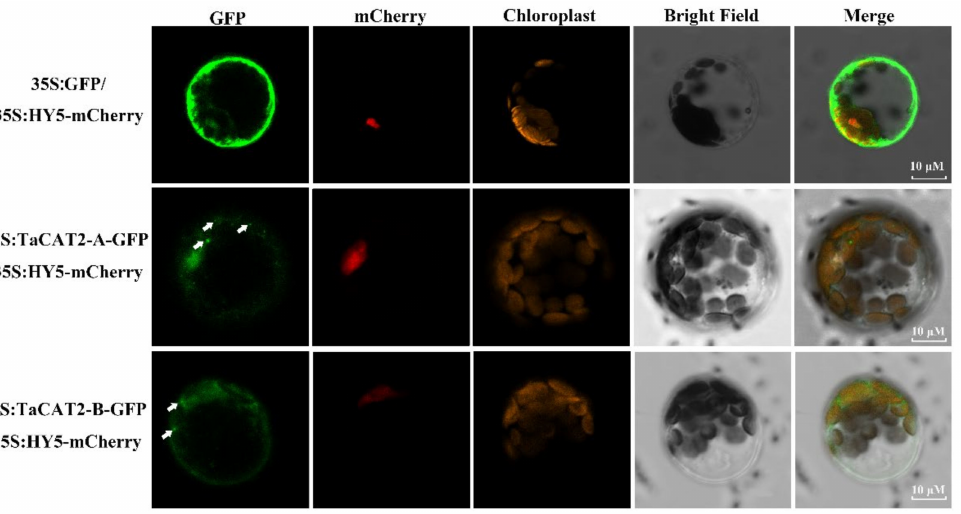
Figure 8. Subcellular localization analysis of TaCAT2-A and TaCAT2-B proteins in protoplast. TaCAT2- A-GFP and TaCAT2-B-GFP fusion protein were transiently expression driven by the 35S promoter in Arabidopsis protoplast. The fluorescence signals were observed under a laser scanning confocal microscopy. The green color represented the GFP fluorescence signals; the red and orange color represented the mCherry and the chloroplast fluorescence signals, respectively. The aggregated proteins were indicated by the white arrows. Scale bars were 10 µ